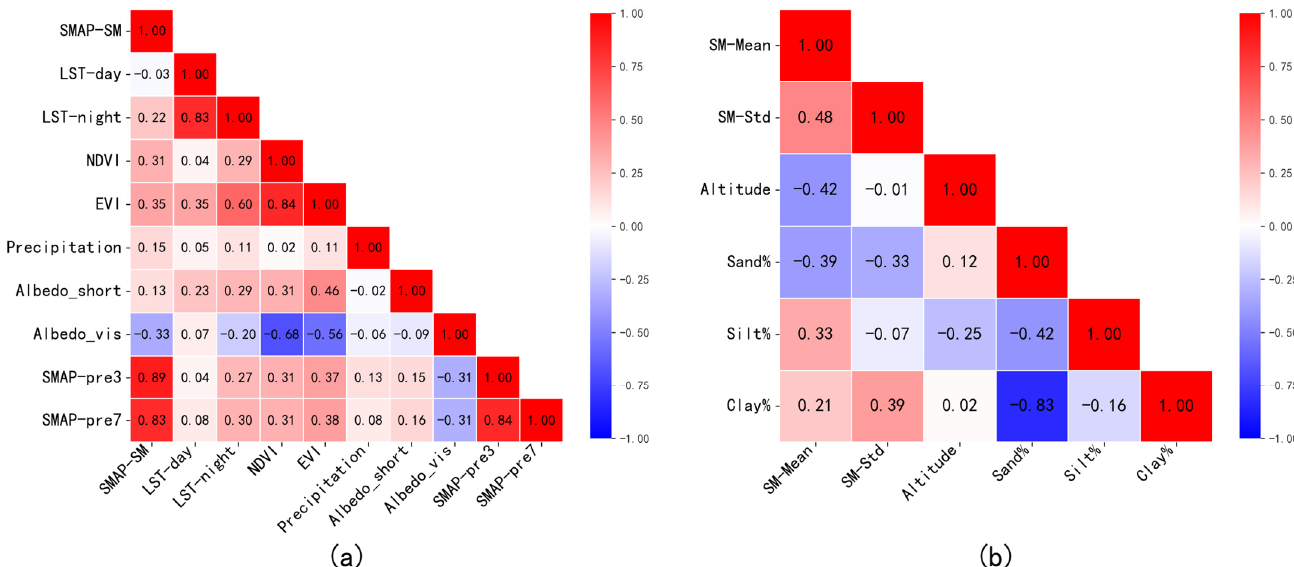
Figure 6. Heatmap of the Pearson correlation coefficient between each variable. ( a ) indicates r heatmap of dynamic variables. ( b ) indicates r heatmap of static variables, SM-Mean (SM-Std) means that the average (standard deviation) of SM in a 36-km cell.